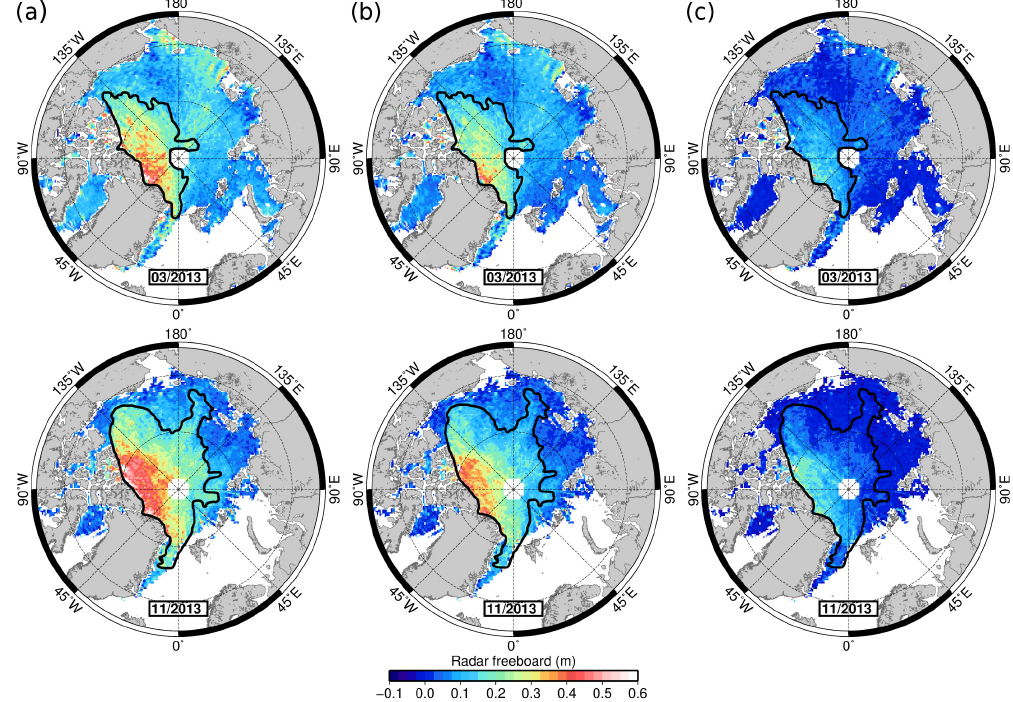
Figure 9. Radar freeboard from different TFMRA (threshold first-maximum retracker algorithm) retracker thresholds for March (upper row) and November (lower row) 2013: (a) 40%, (b) 50% and (c) 80% threshold. The black polygon defines the averaged MYI zone, retrieved from the OSI SAF ice-type product.